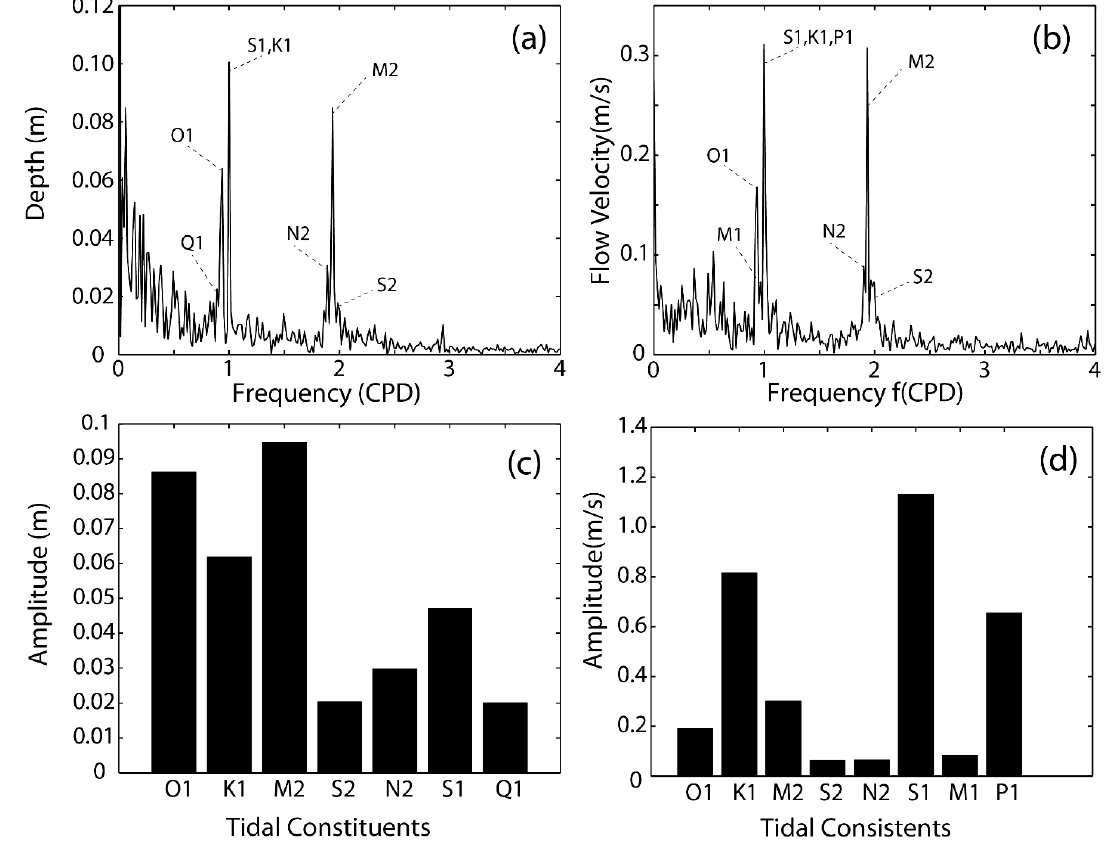
Figure 3. Results of FFT and harmonic analysis: spectrum for ( a ) water level and ( b ) along channel velocity; tidal constituents from the harmonic analysis for ( c ) water level and ( d ) along channel velocity. Units here are m for water level and m/s for the along channel velocity.